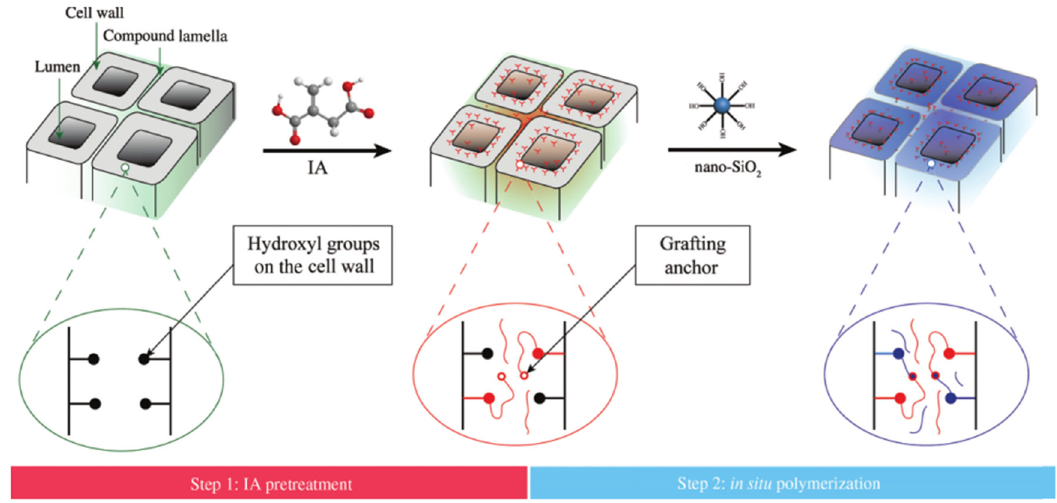
Figure 17: Schematic of the modi fi cation process: functionalization of the wood cell wall – OH groups with IA, followed by in situ poly - merization of nano - SiO 2 [ 149 ]